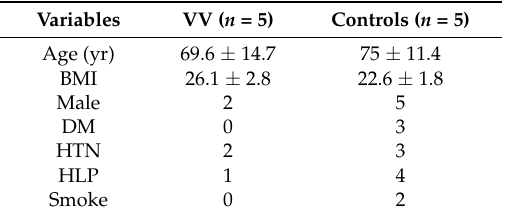
Table 1. Clinical characteristics of patients of the two